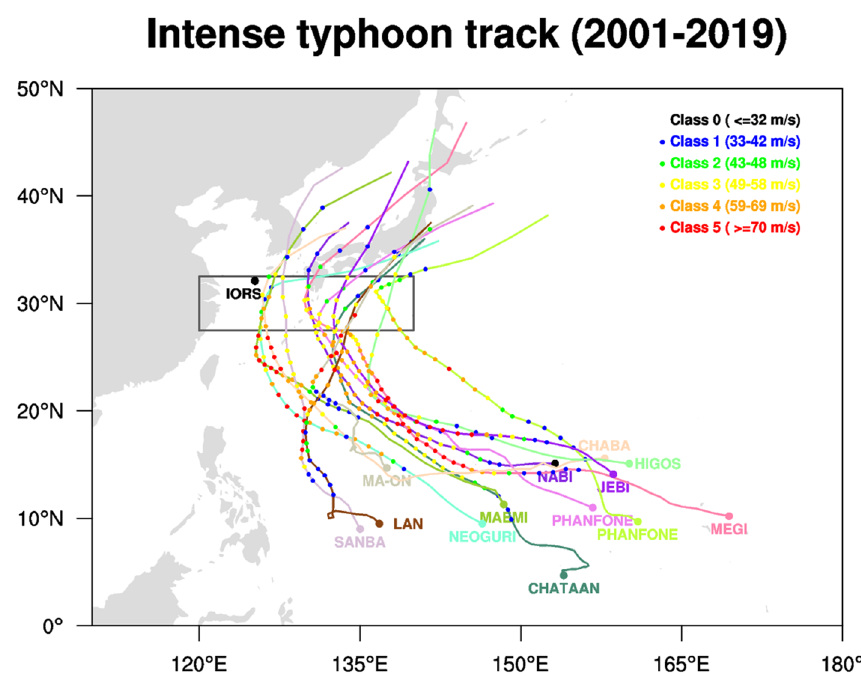
Figure 1. Typhoons with intensities above class three coming through the domain [120°–140°E, 27.5°–32.5°N] from 2001 to 2019 (the map was drawn using NCAR Command Language Version 6.4.0; https:// www. ncl. ucar.